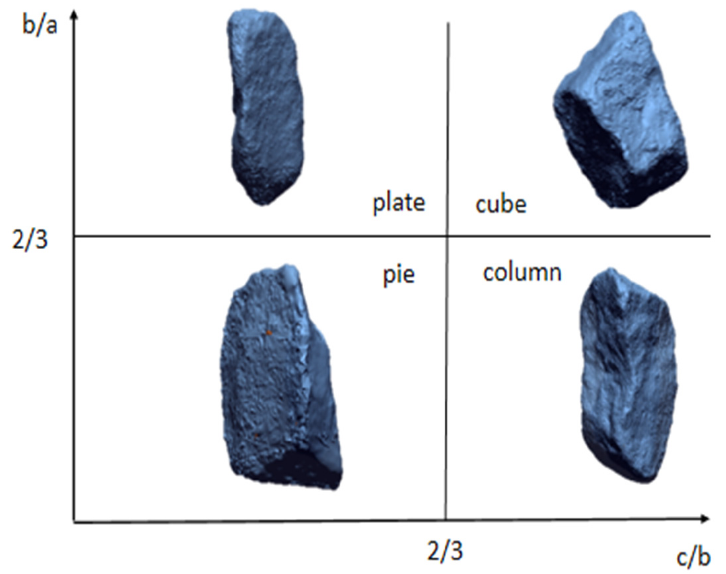
Figure 13. Shape division of coarse aggregate.